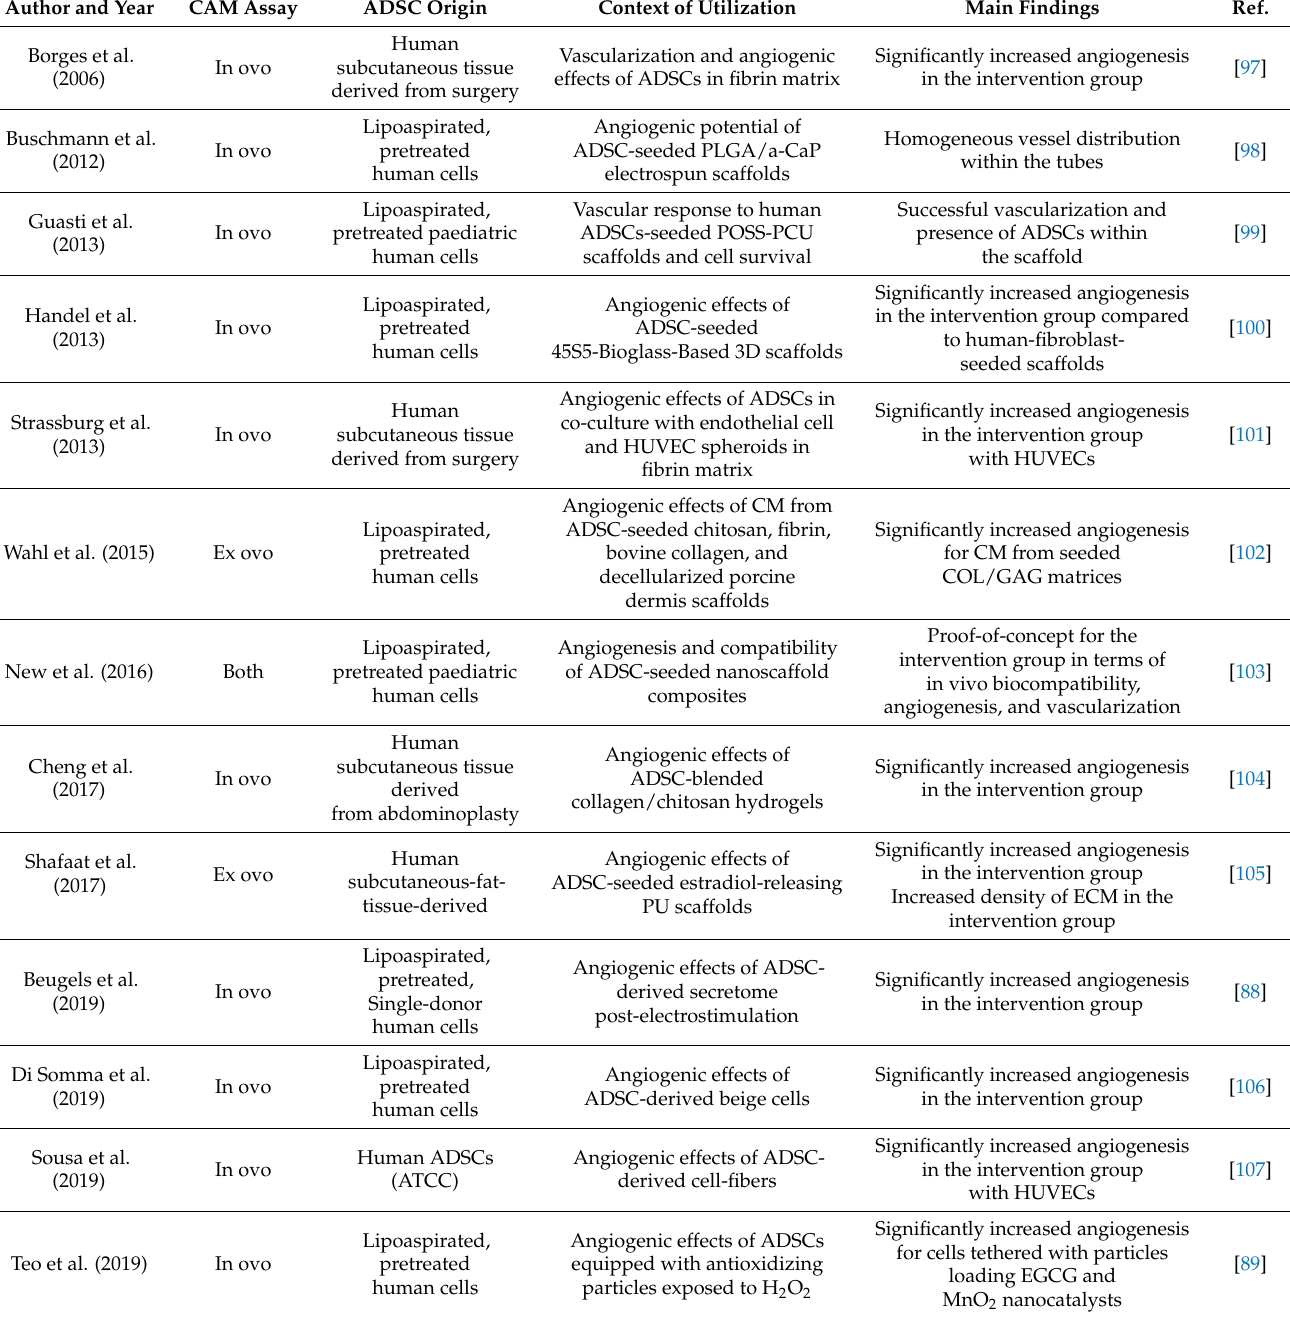
Table 1. Overview of studies utilizing CAM assay in the context of adipose stem cell